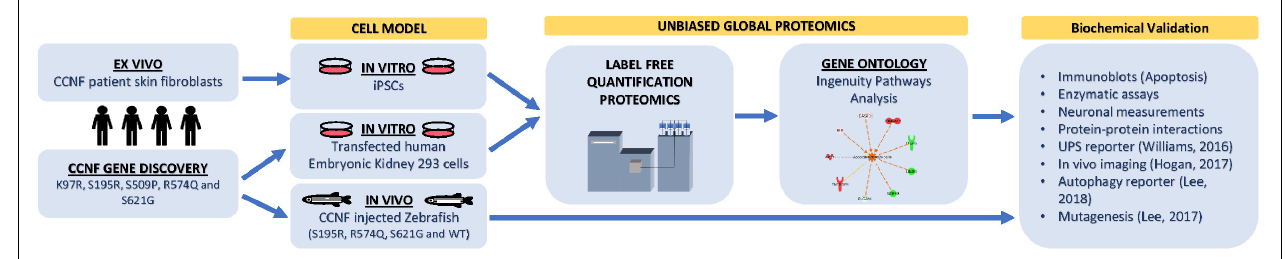
FIGURE 1 | Proteogenomic workflow to determine whether potential ALS gene candidates cause disease. Discovery of gene mutations by whole-genome, whole-exome, or targeted sequencing. cDNA gene constructs candidate mutations are inserted into cell models (e.g., HEK293 or Neuro2A cells). Ex vivo models such as patient fibroblasts (if available) that contain the gene mutation can also be used or converted into iPSCs for further differentiation. Label-free quantitative proteomics is used to analyze and provide a profile of protein expression changes that cluster to biological processes and signalling pathways. These biological pathways can then be validated using standard biochemical methods and/or in animal models. Animal models, such as zebrafish, have the advantage of generating progeny relatively quickly and can be extended to study motor